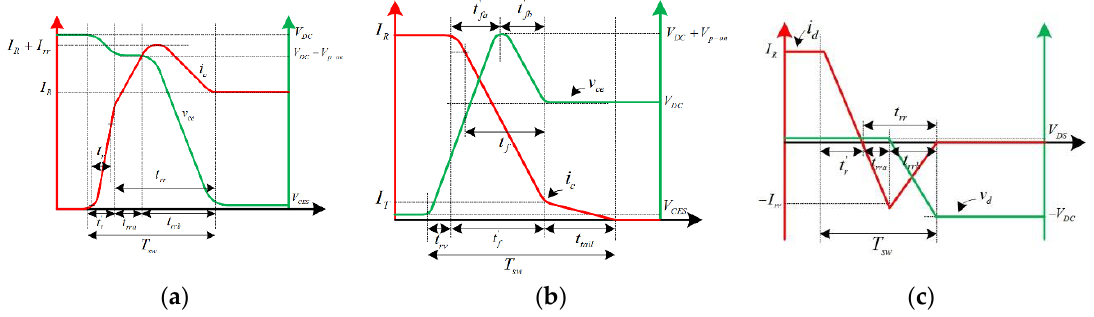
Figure 4. Non-linear characteristic IGBT switching process. ( a ) IGBT Turn on, ( b ) IGBT Turn off, ( c ) Diode turn off.